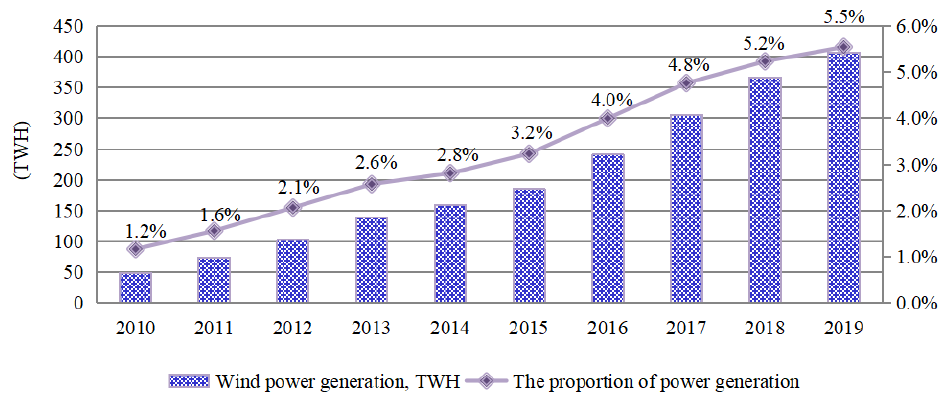
Figure 8. China’s annual output of wind power in 2010 – 2019.